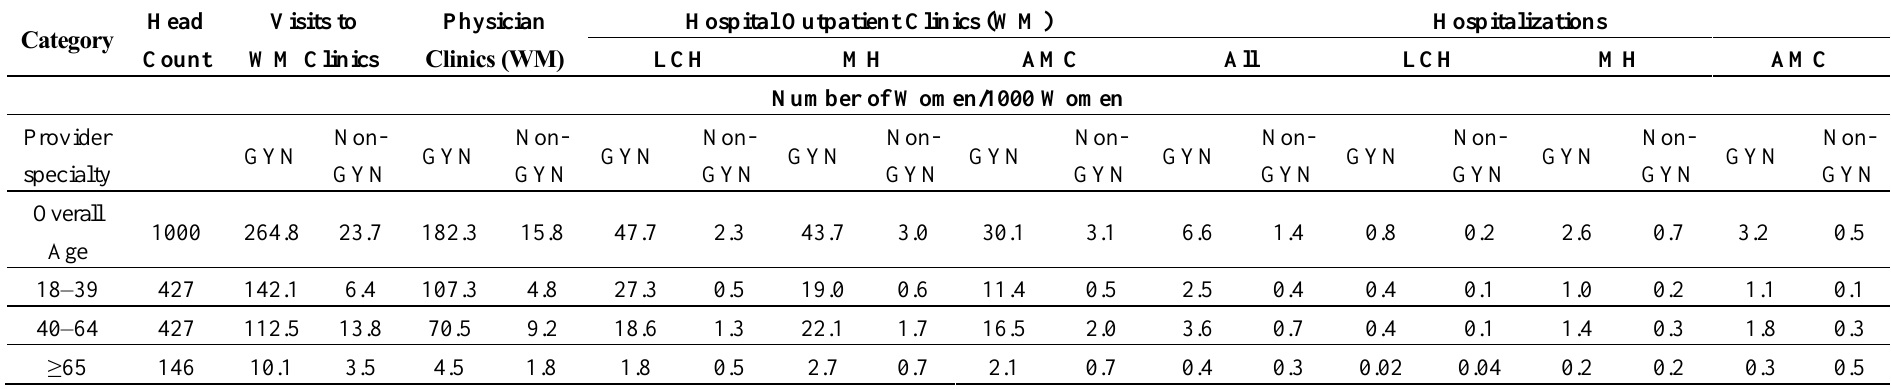
Table 2. Estimates of ecology of gynecological care in Taiwan in terms of type of care, stratified by patient age group and provider specialty.